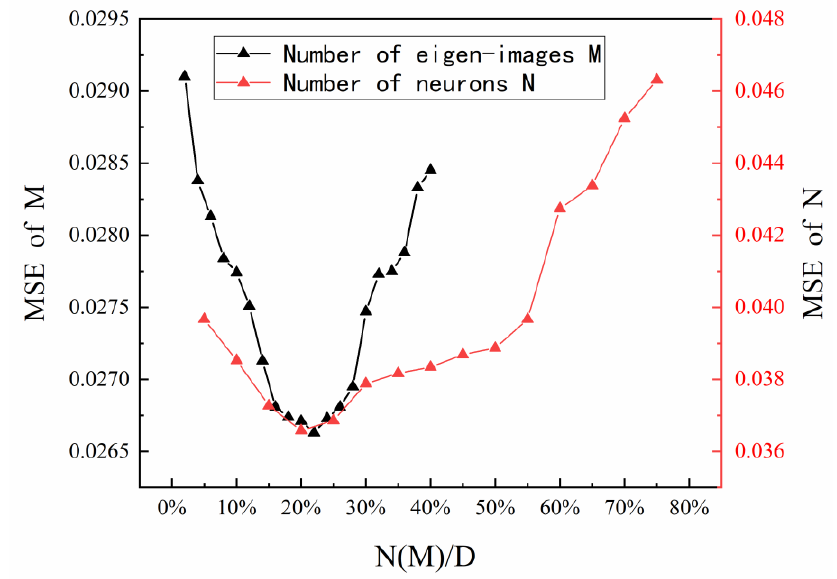
Figure 8. The influence of number of feature images and number of neurons on prediction accuracy.